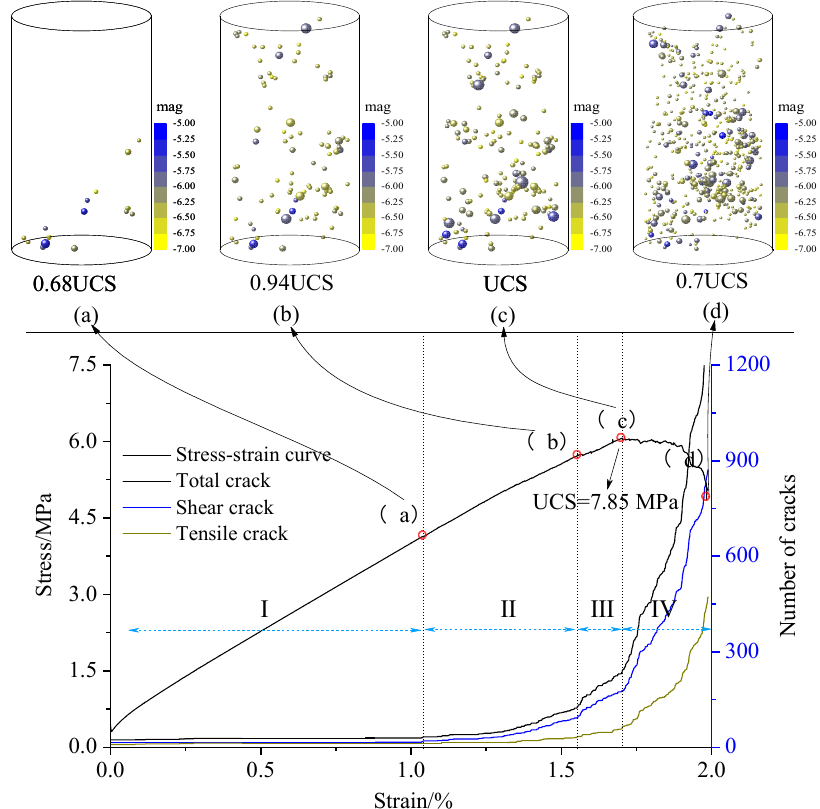
Figure 7. Stress–strain curve and number of cracks; upper snapshots show source distributions at different stages. I, II, III, and IV are the stages of crack generation, which are pore compaction stage, fracture expansion stage, peak stress stage and post peak stage, respectively.